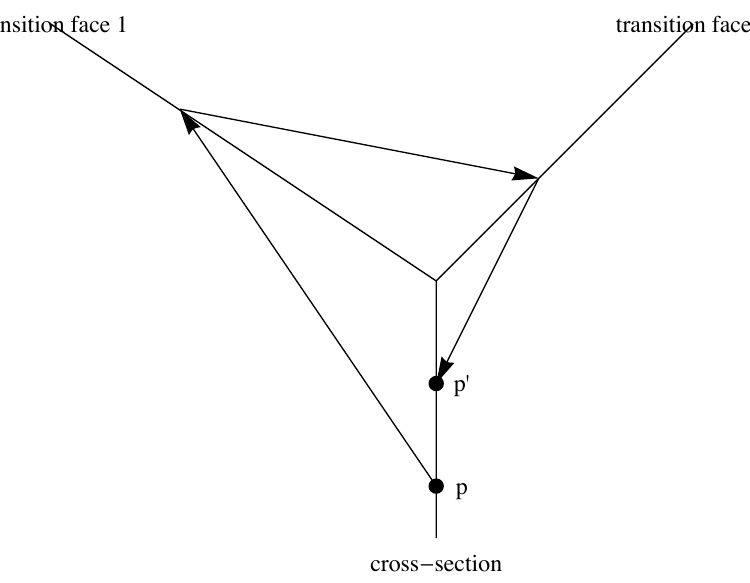
Figure 3. A simplified drawing of the kind of return map we will use